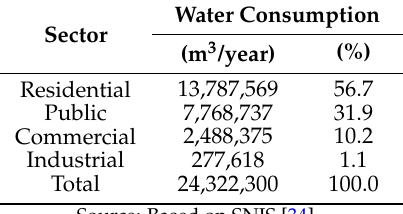
Table 9. Water consumption per sector in Florianópolis in 2006.